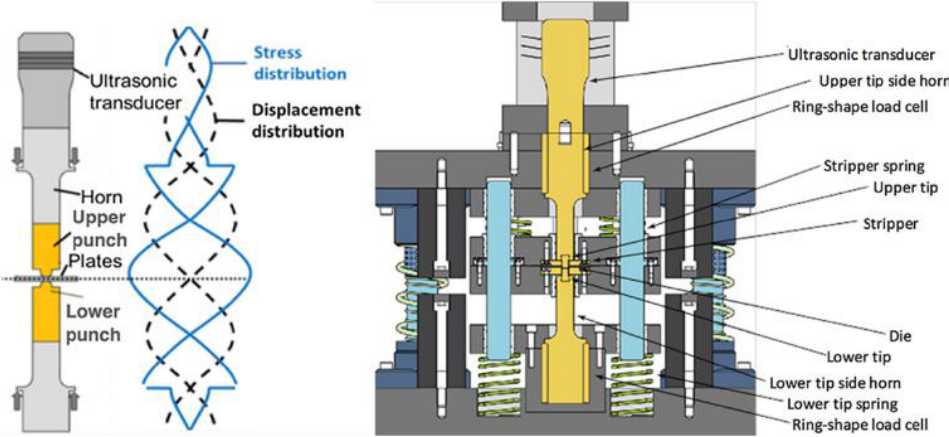
Figure 31. Schematic diagram of perpendicular ultrasonic joining [53].